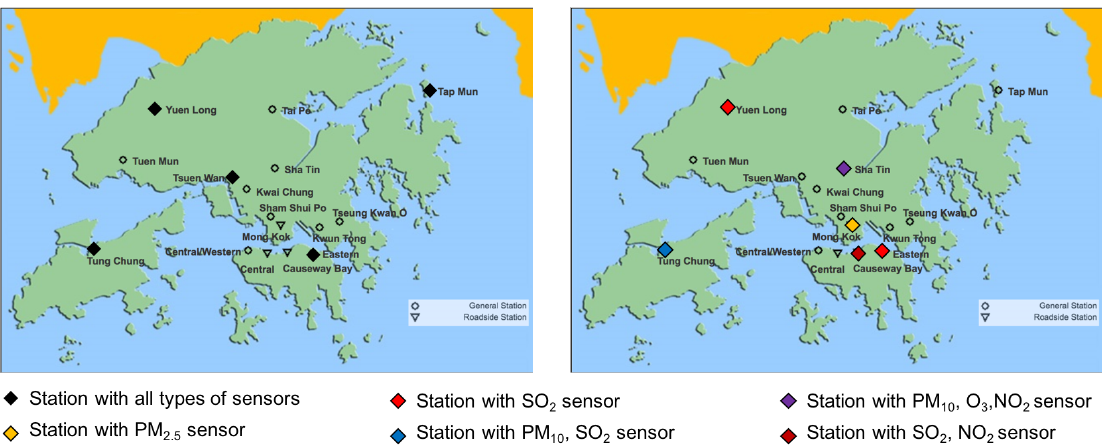
Figure 7. Placement results for the general case when the budget is 100, the cost is c 1 = c 2 = c 3 = c 4 = c 5 = 1, c site = 15. The left figure is the placement result with the cost-effective greedy selection. The right figure is the placement result with the greedy